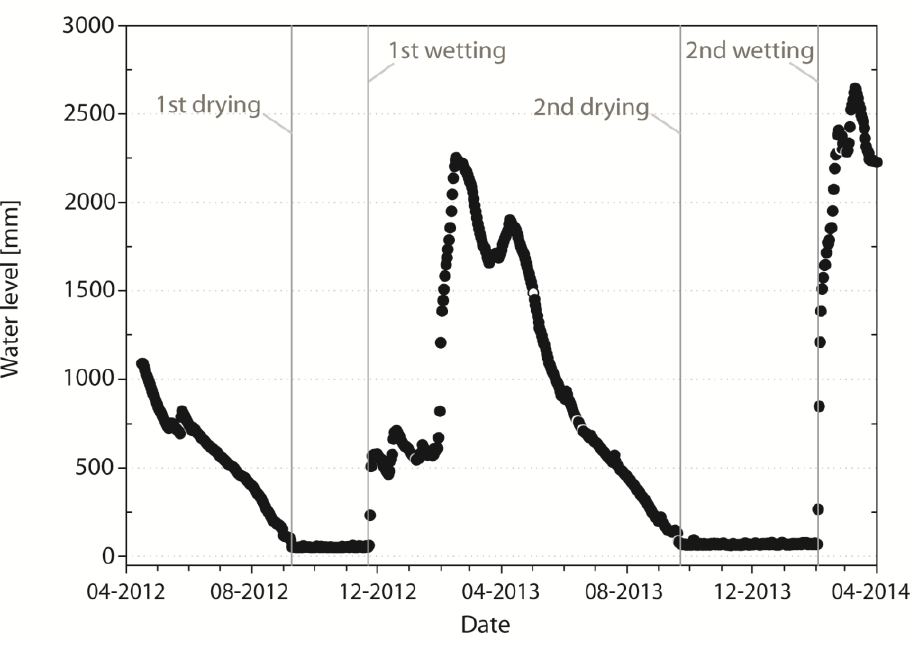
Figure 3. Observed water level for water body B (Figure 1) for the study period (1 April 2012–30 March 2014) indicating 1st drying, 1st wetting, 2nd drying and 2nd